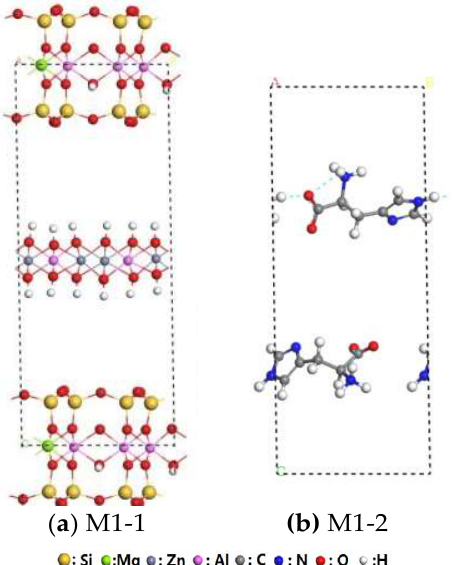
Figure 5. Structural models of LDHs–MMT lamellae and histidine; ( a ): LDHs–MMT structure; ( b ): histidine structure in M1.